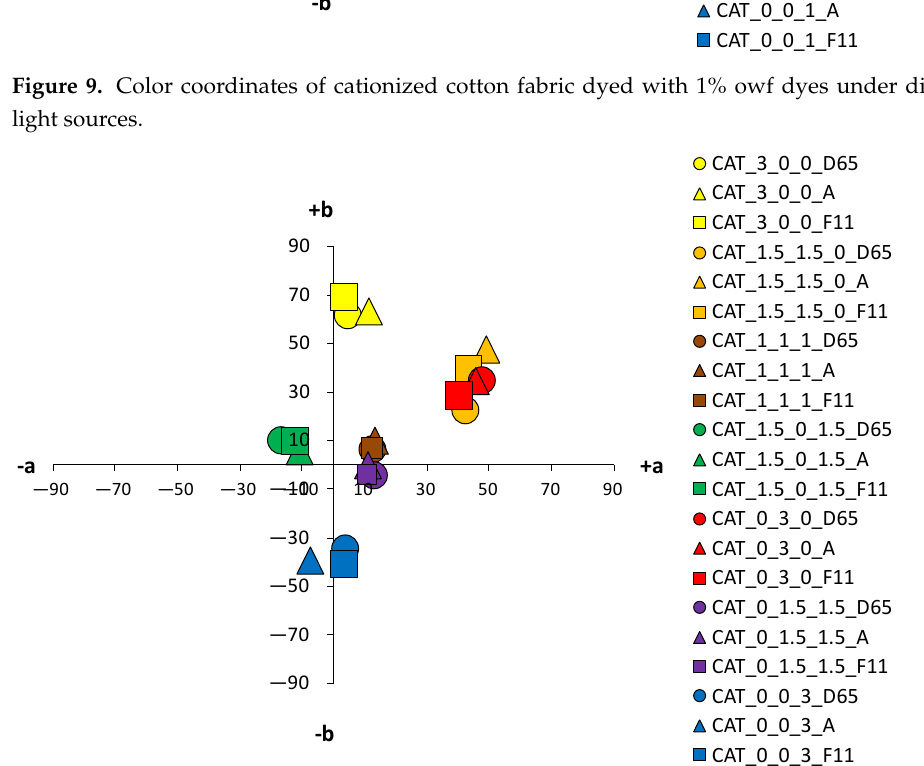
Figure 10. Color coordinates of cationized cotton fabric dyed with 3% owf dyes under different light sources. The color parameters of standard and cationized fabrics dyed with 1% owf vat dye are shown in Table 3. For samples dyed in primary color hues (yellow, red, and blue), in the case of yellow coloration, a significant shift in the color hue with respect to cationiza- tion is observed from the yellow – green spectrum (standard fabric h = 95.69°) to the yellow spectrum (cationized fabric h = 90.98°). No significant change of color hue with respect to cationization was observed for red and blue coloration. Fabrics dyed with a dye mixture show a significant effect of cationization on the change in color hue. For the green fabrics dyed with a mixture of yellow and blue dye at concentration of 0.5%, there is a shift in hue from blue-green spectrum of the standard fabric (h = 236.72°) to the green spectrum of the cationized one (h = 183.28°). Analyzing chroma (C*) and hue (h°) of each dye from the mixture, yellow and blue, it is found that cationization significantly affects the exhaustion of the yellow dye compared to blue. Thus, this effect is also seen in the mixture, where the exhaustion of the yellow dye is